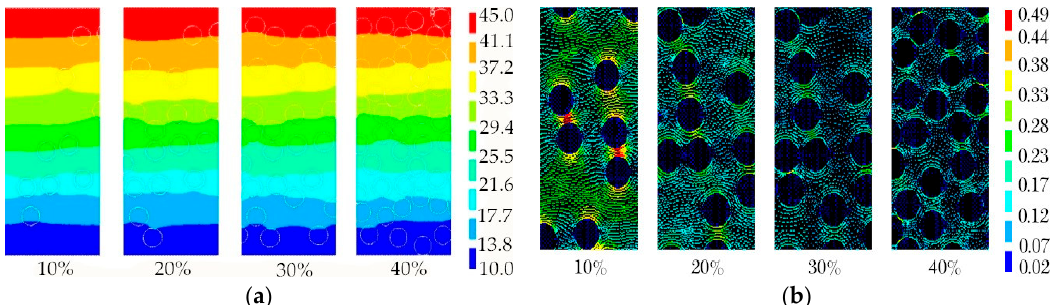
Figure 6. ( a ) Temperature nephogram; ( b ) Thermal vector nephogram.